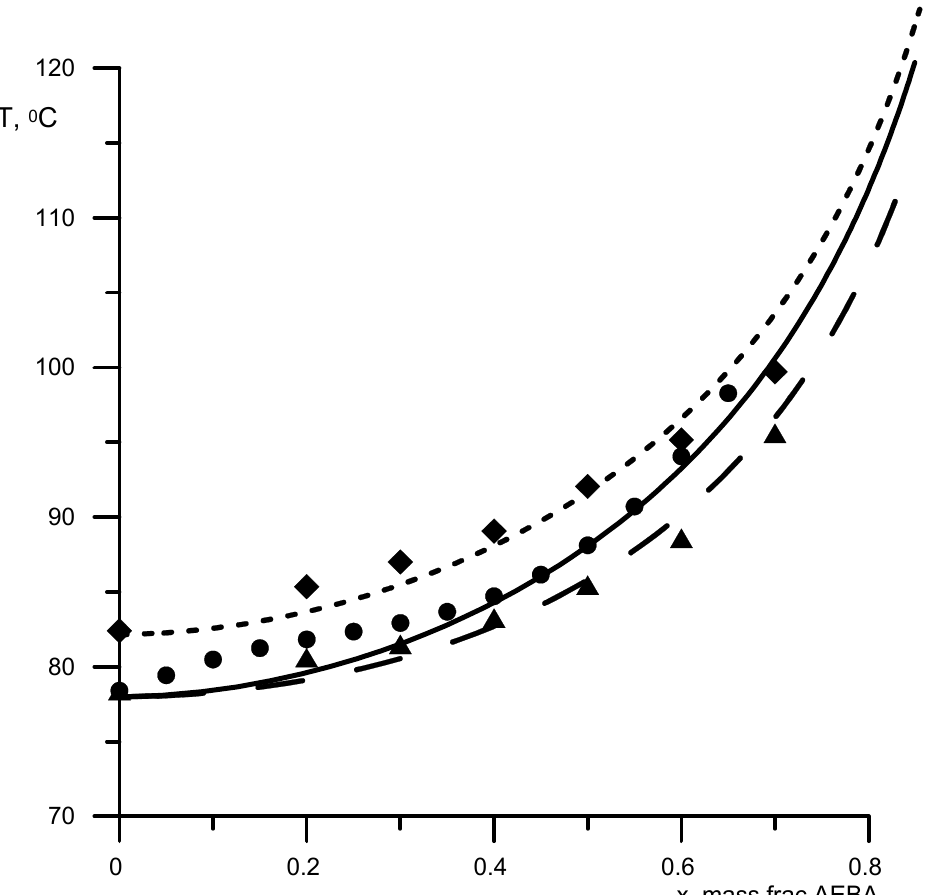
Figure 3. Boiling points of aqueous AEBA solutions at atmospheric pressure. Geometric figures are experimental values (circles—AEBA-diethylene glycol (DEG); triangles—AEBA-TEG), and lines are calculated values.